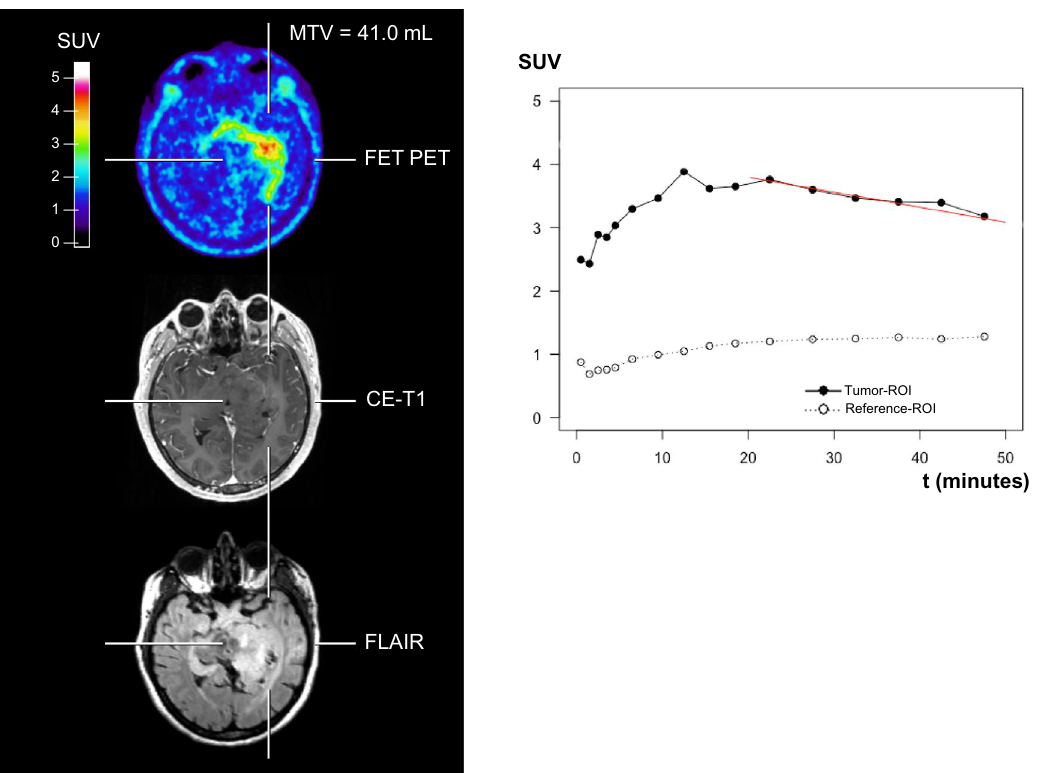
Figure 1. Representative neuroimages including FET PET, contrast-enhanced and FLAIR-weighted MRI, and the TAC of a patient (patient #6) with an IDH-wildtype anaplastic astrocytoma (WHO grade III) and prognostically unfavorable static and dynamic FET PET parameters (MTV = 41.0 ml; TBR mean = 2.2; TTP = 13 min). The patient had an unfavorable outcome with a PFS of 6.7 months and an OS of 14.0